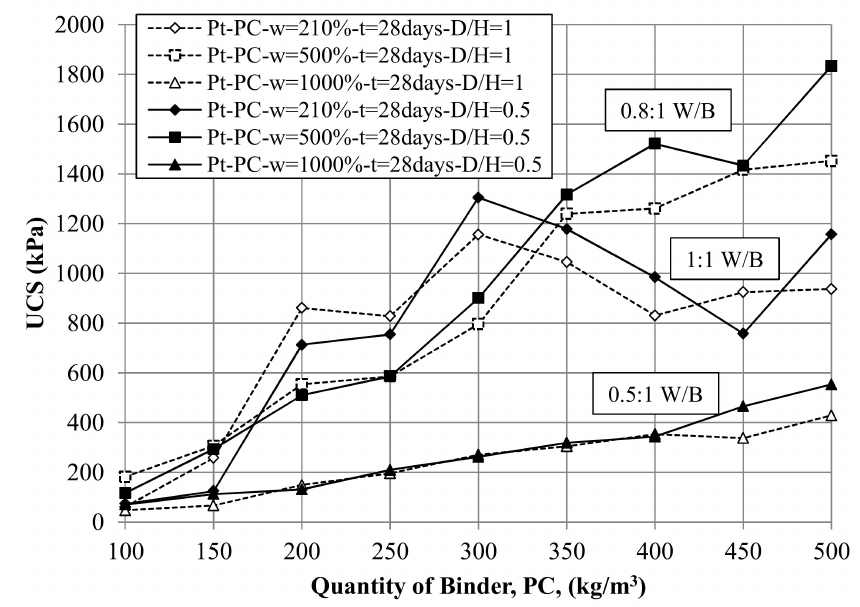
Figure 11. Effect of quantity of binder ( PC ) and water/binder ratio on UCS at 28